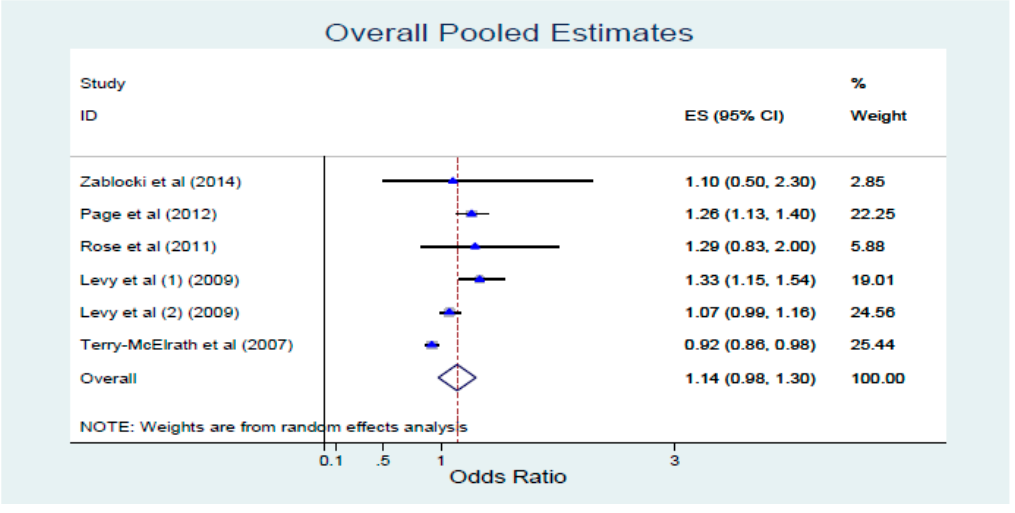
Figure 2. Overall pooled estimates.